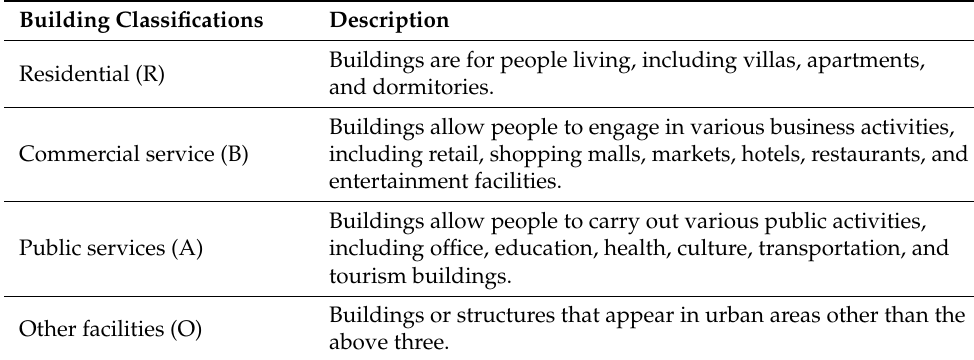
Table 1. Description of building class in the